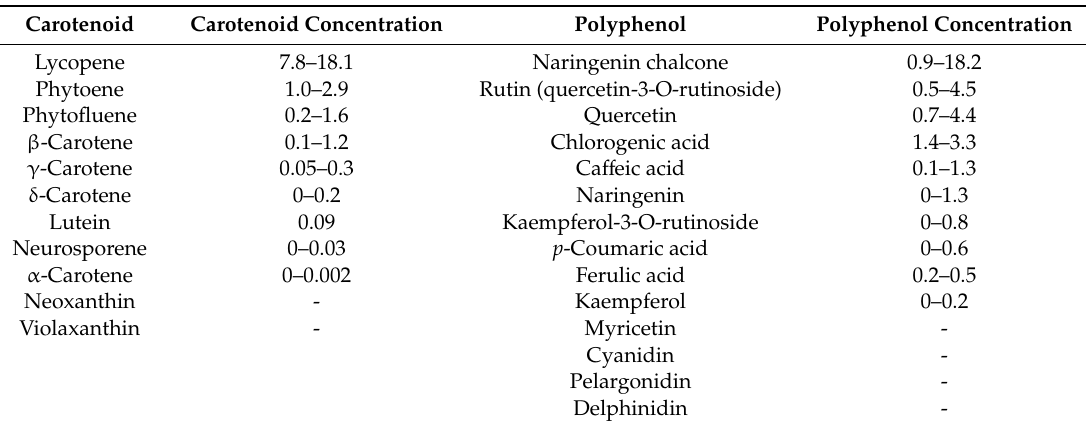
Table 1. Content of the main carotenoids and polyphenols found in tomato ripe fruits from di ff